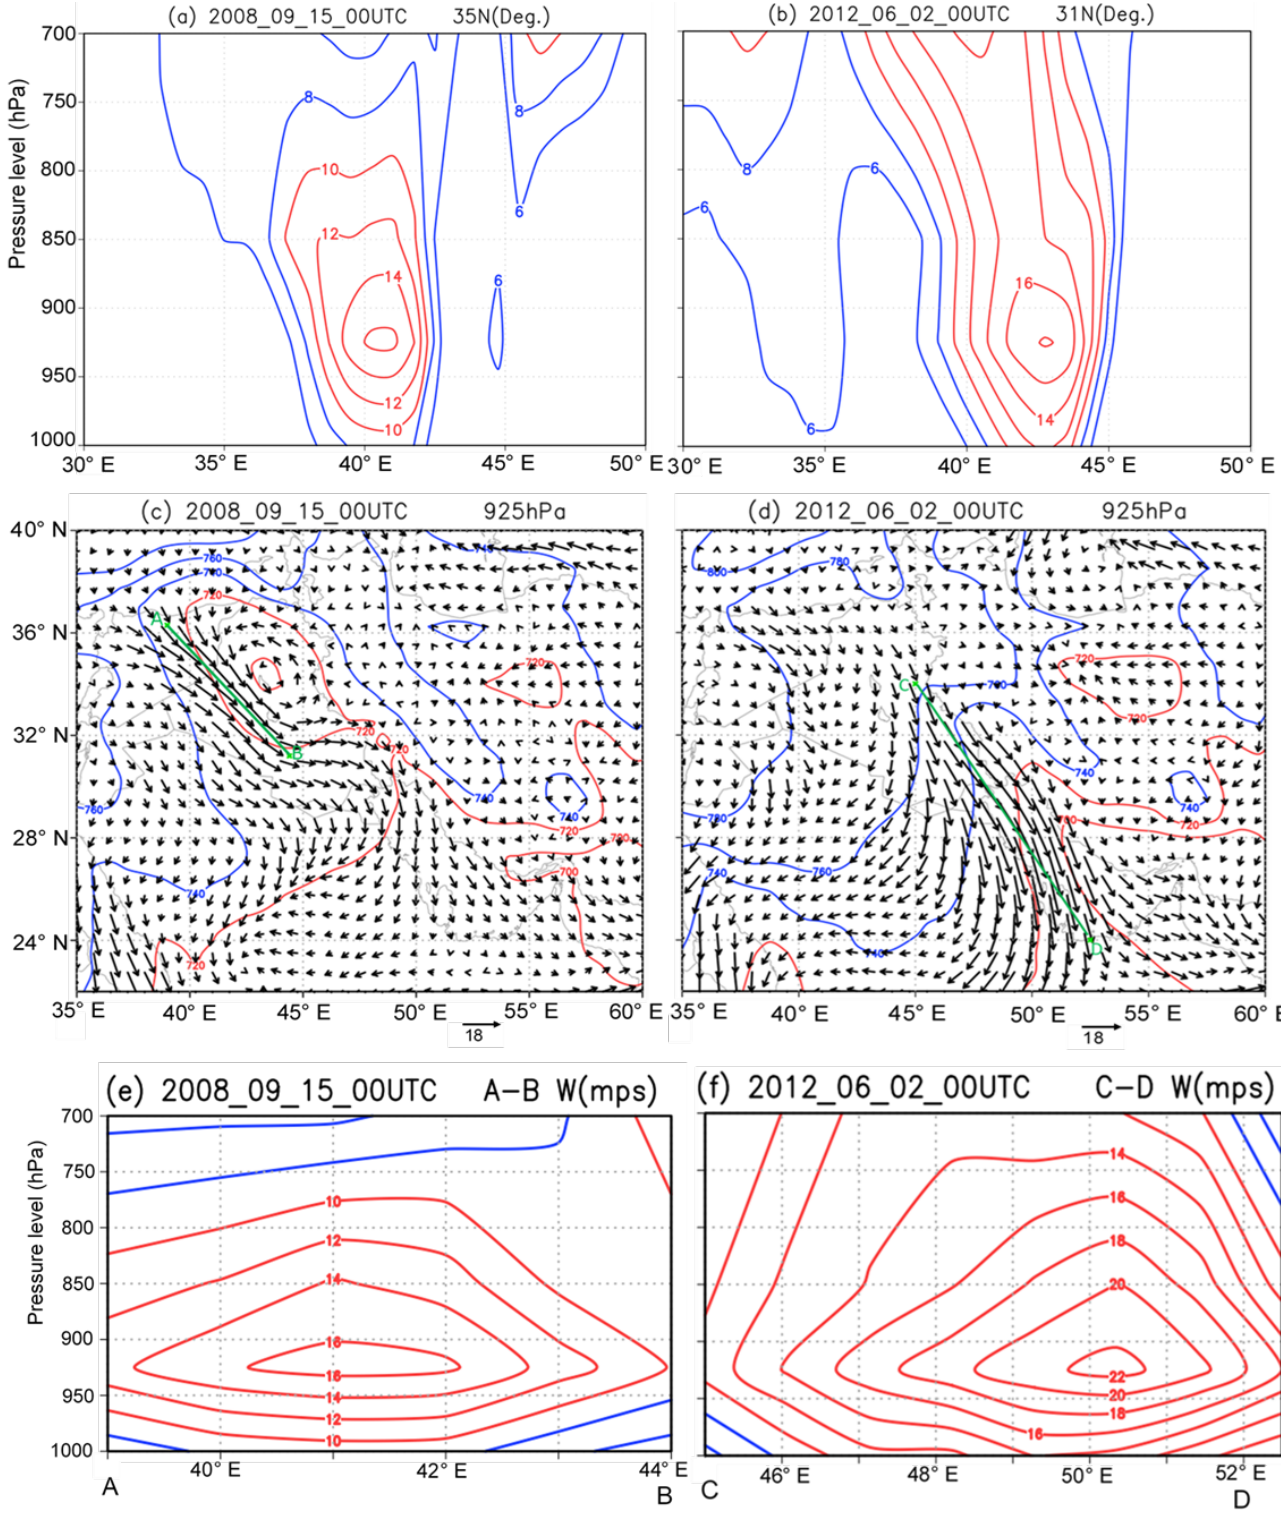
Figure 5. Vertical cross-section, from 1000 to 700 hPa of wind speed; ( a ): at latitude 35 ◦ N; ( b ): at latitude 31 ◦ N; ( c , d ): 925-hPa geopotential height and wind vectors (ms − 1 ); ( e , f ): vertical cross-section of wind speed along the green lines from A to B and C to